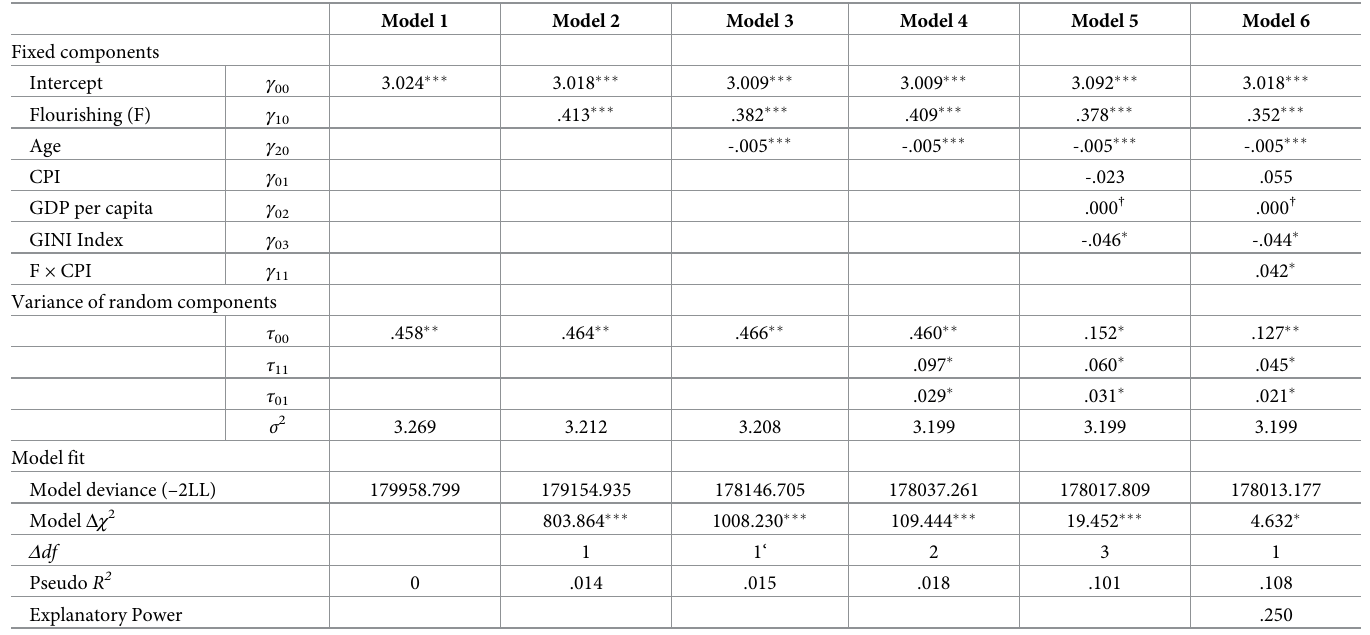
Table 3. Parameter estimates for the six models examining the relation of helping distant others on flourishing and CPI in Study